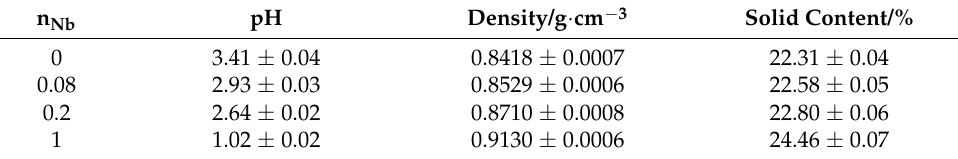
Table 1. The influence of n Nb on the pH value, density, and solid content of Nb/SiO 2 sol. n Nb pH Density/g · cm − 3